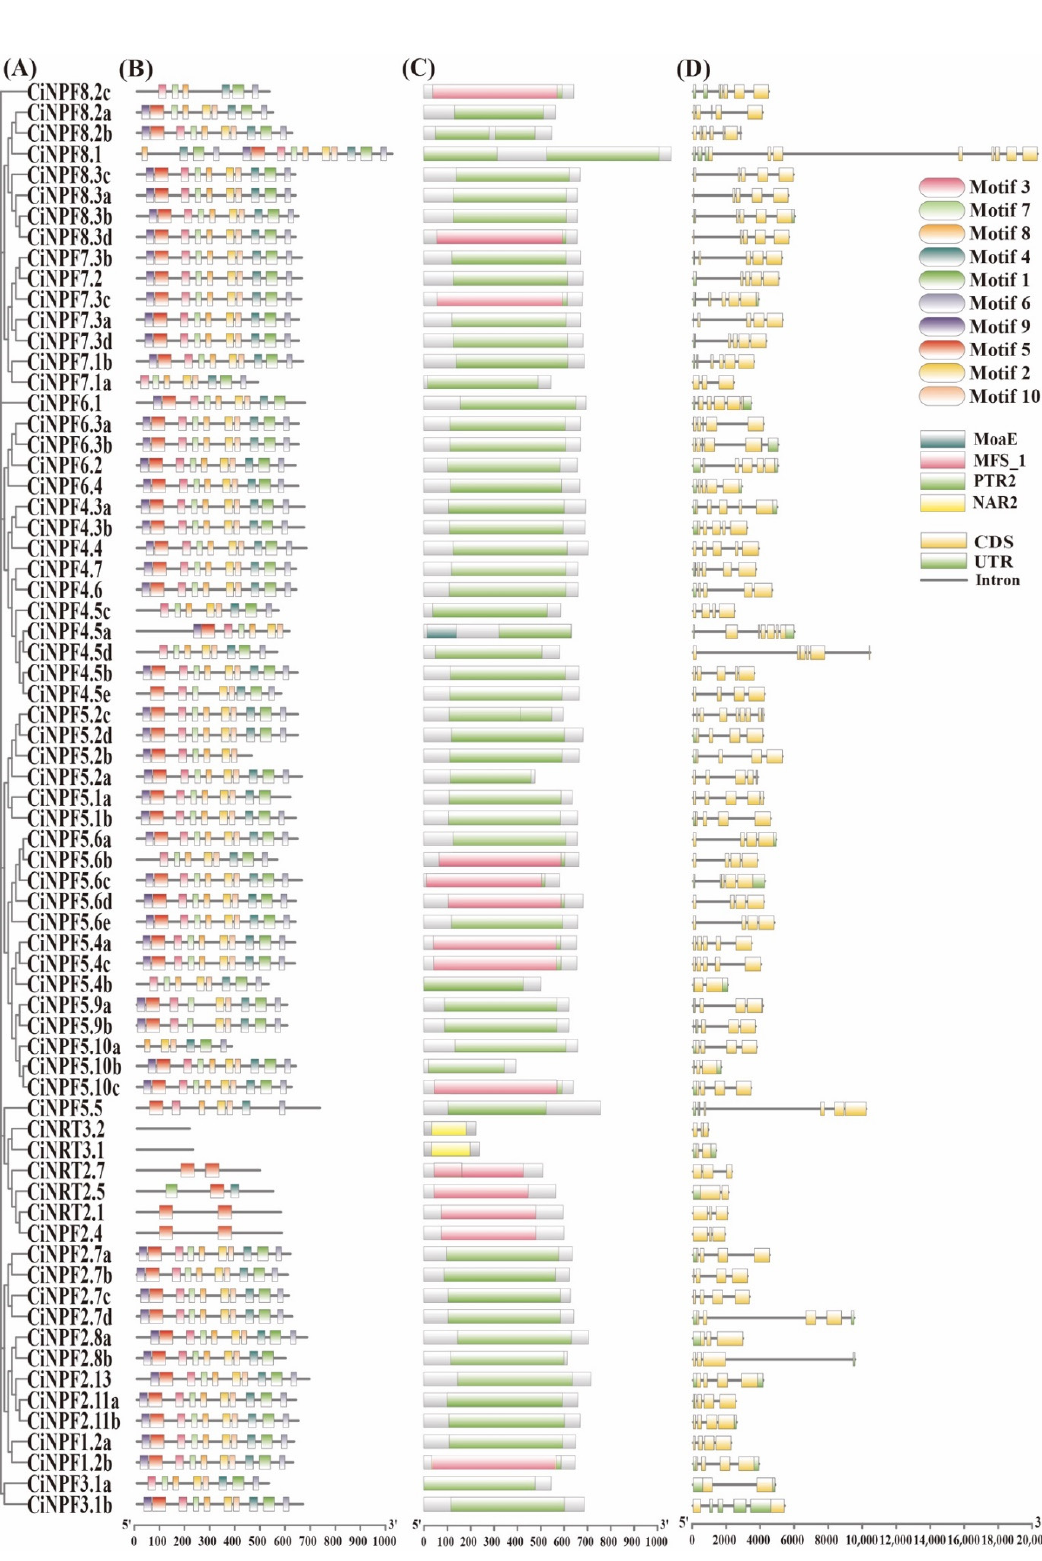
Figure 4. Phylogenetic analysis, conserved motif, conserved domain and gene structural of the NRT genes in pecan. Phylogenetic analysis of the NRT genes in pecan ( A ). The conserved motifs of the NRT genes in pecan ( B ). The conserved domain of the NRT genes in pecan ( C ). The gene structure of the NRT genes in pecan ( D ).